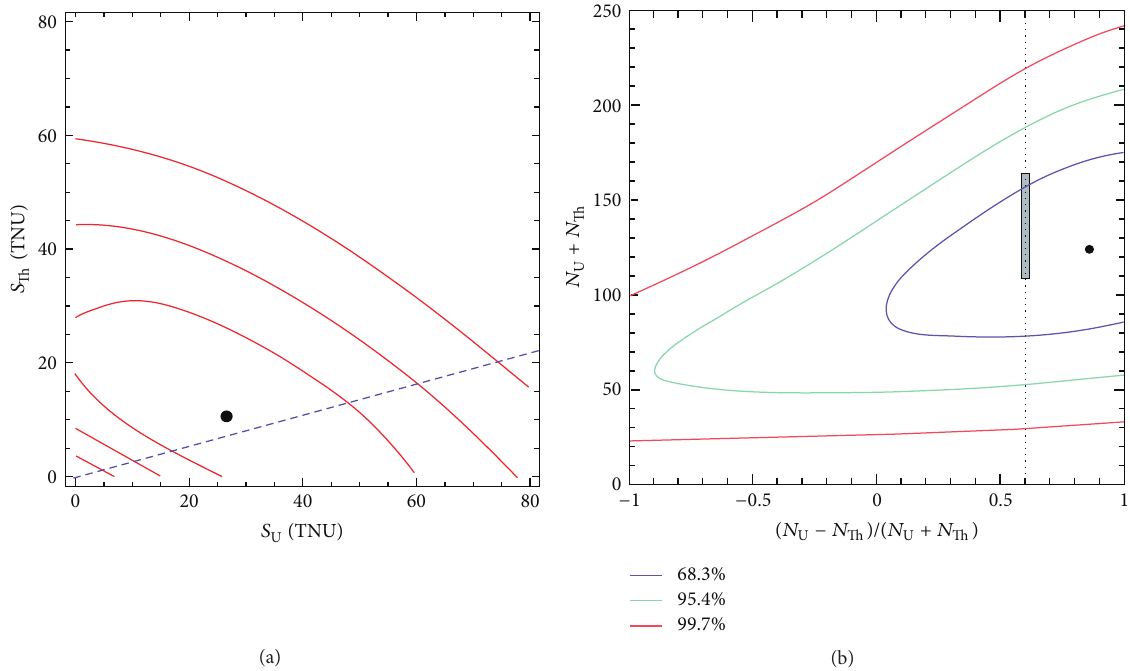
Figure 8: (a) The 68.3, 95.4, and 99.7% contour plots of the Th versus U signal, expressed in TNU units, in the Borexino geoneutrino analysis [62]; the dashed blue line is the expectation for a chondritic Th/U mass ratio of 3.9. (b) the same confidence level contours are shown for the KamLAND analysis [51], expressed in number of total events versus the normalized difference of the number of events from U and Th. The vertical dashed line represents the chondritic ratio of 3.9 while the shadowed area on this line is the prediction of the BSE model from [17].